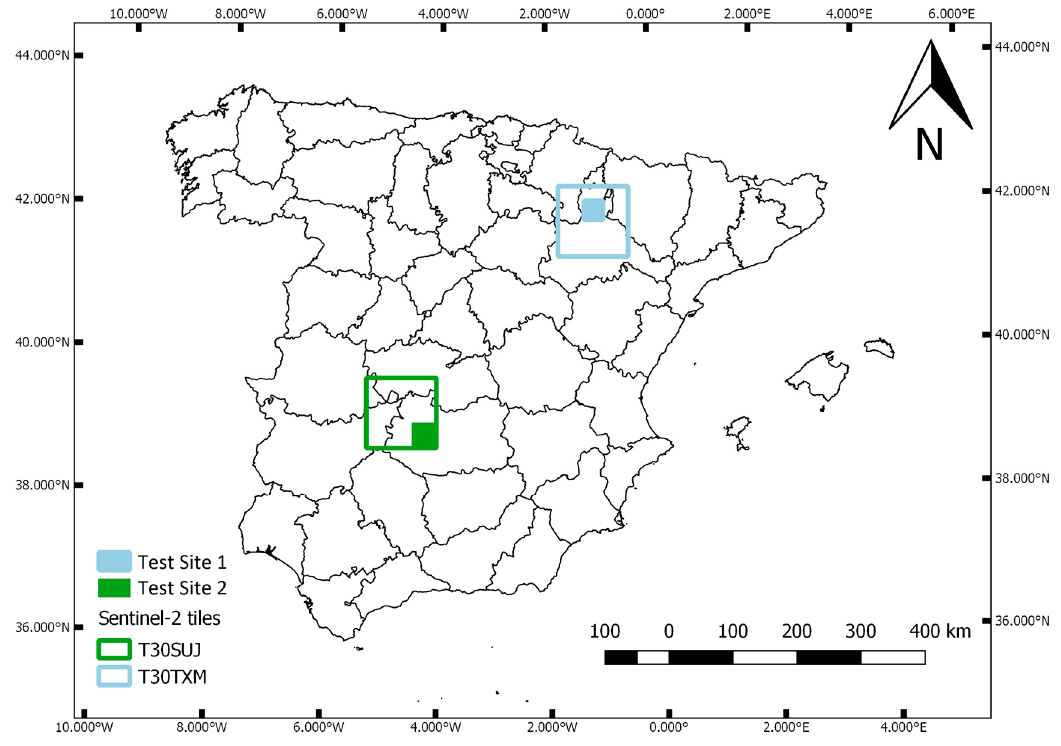
Figure 2. Pilot areas distribution.